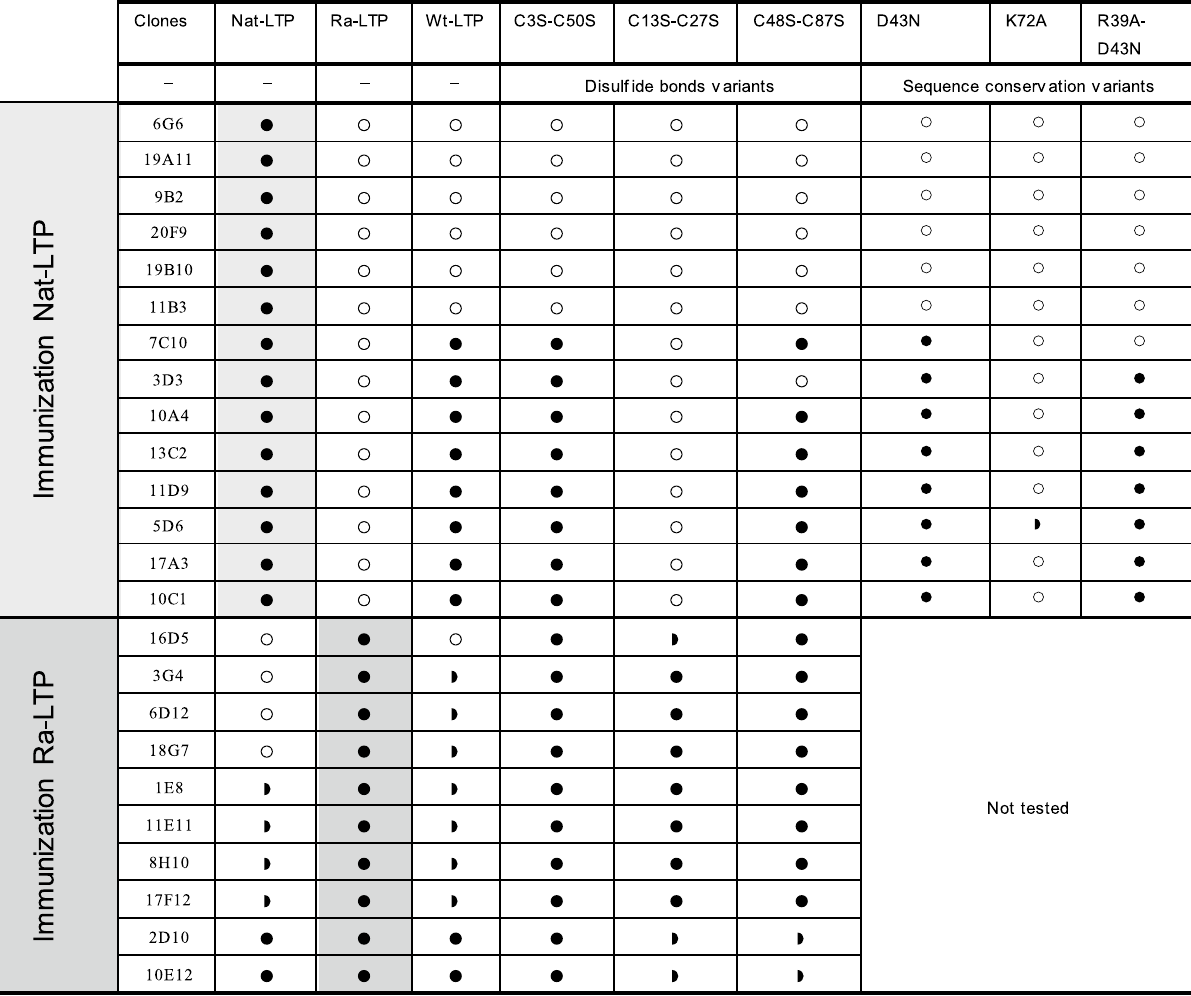
Table 2. Monoclonal mouse antibody reactivity. Reactivity of monoclonal antibodies obtained by immunization with LTP1 in its native form (Nat-LTP) or after reduction/alkylation (Ra-LTP). Reactivity against Nat-LTP, Ra-LTP or the tested Mut-LTP variants was found to be equivalent ( ● ), reduced but positive ( )